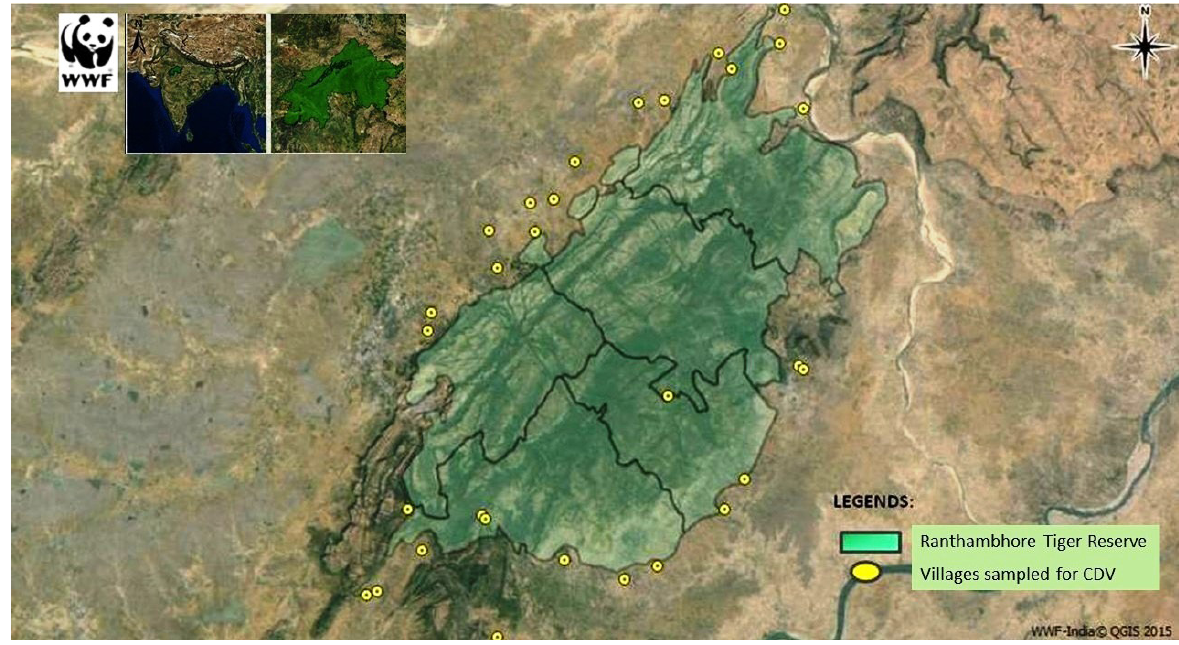
Figure 1. Villages sampled around Ranthambhore Tiger Reserve in Rajasthan,